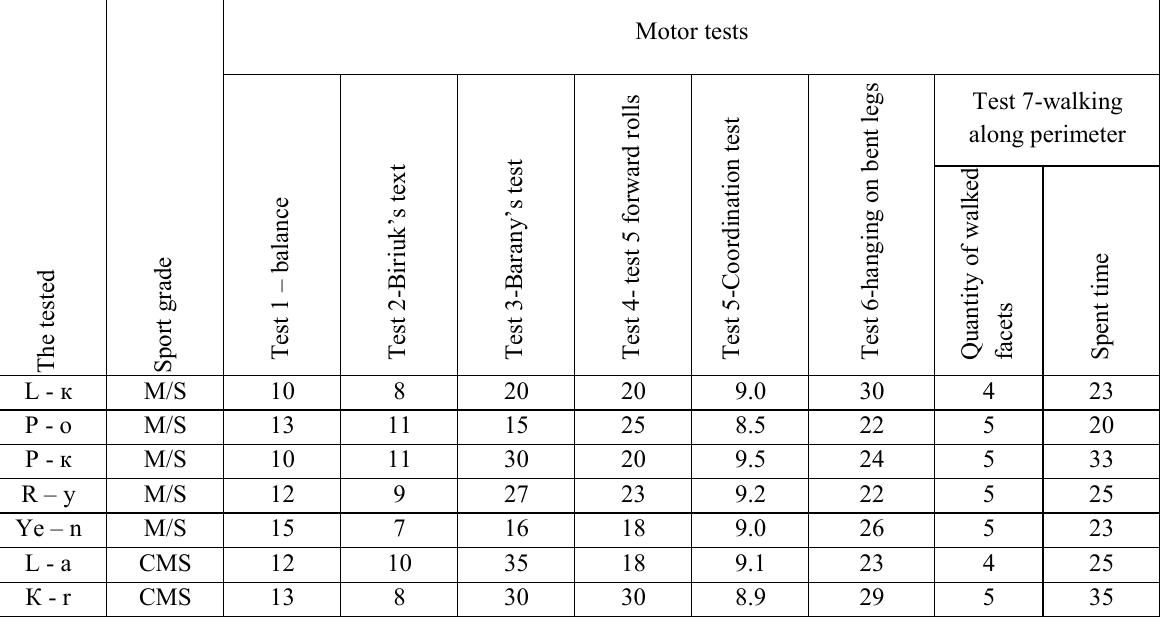
Initial indicators of sensor-motor coordination of first year students (NUPESU), specializing in sport gymnastic